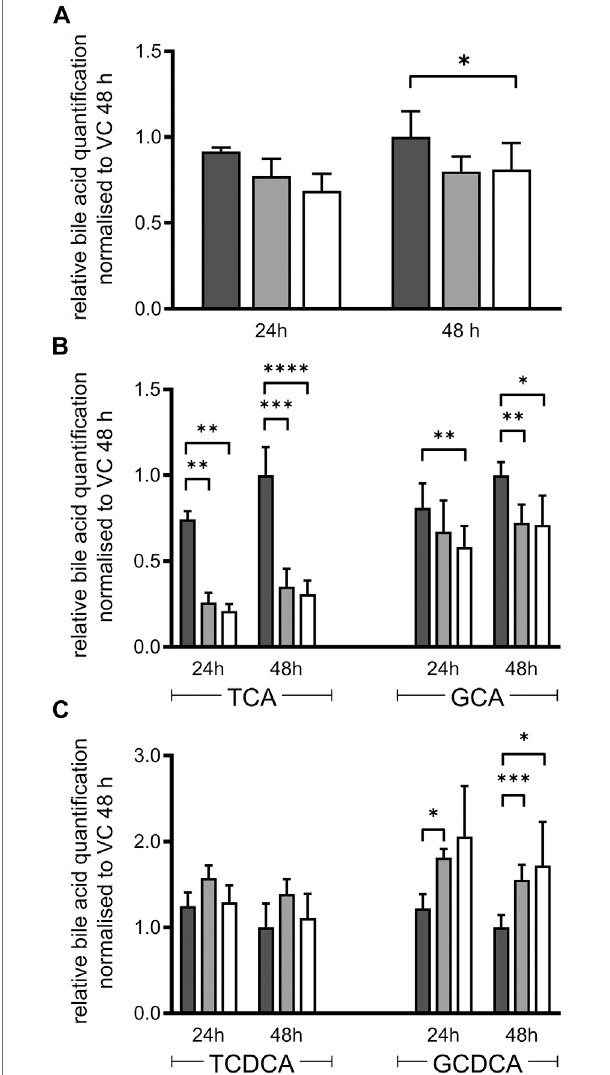
FIGURE 3 | Bile acid secretion of HepaRG cells. Relative bile acid secretion into medium of HepaRG cells transduced with vector control (black) or sgRNAs POR#1 (light grey) and POR#2 (white) and differentiated for 2 weeks was analyzed after 24 and 48 h after serum depletion by ESI LC-MS/MS. Respective bile acid amount secretedby HepaRG VC cells at 48 h was set to 1 (A) : Sum of all bile acids measured: cholic acid, chenodeoxycholic acid, taurocholic acid (TCA), glycocholic acid (GCA), taurochenodeoxycholic acid (TCDCA), glycochenodeoxycholic acid (GCDCA) (B) :SecretionofTCAandGCA (C) :SecretionofTCDCAandGCDCA.Shown are means and SD of 3-7 independent measurements. Statistical signi fi cance wasassessedbytwo-way ANOVAwithBonferronicorrection(* p < 0.05,** p < 0.01, *** p < 0.001, **** p <